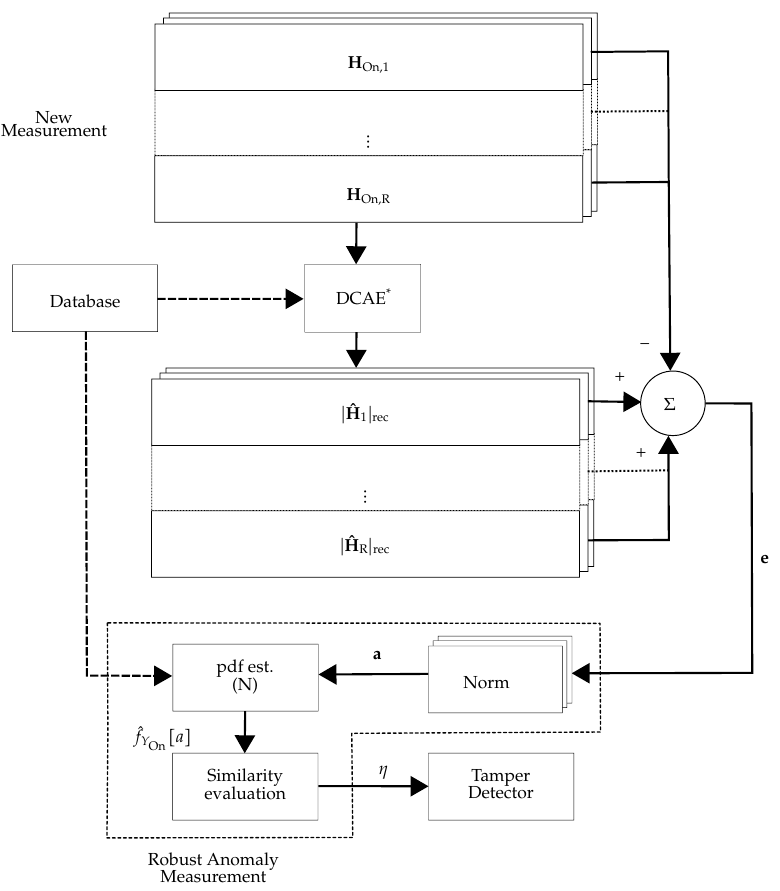
Figure 6. Schematic view of the online phase of centralized processing: In the online phase, DCAE * is used to calculate its anomaly score and the pdf approximation of the anomaly score ( ˆ f Y